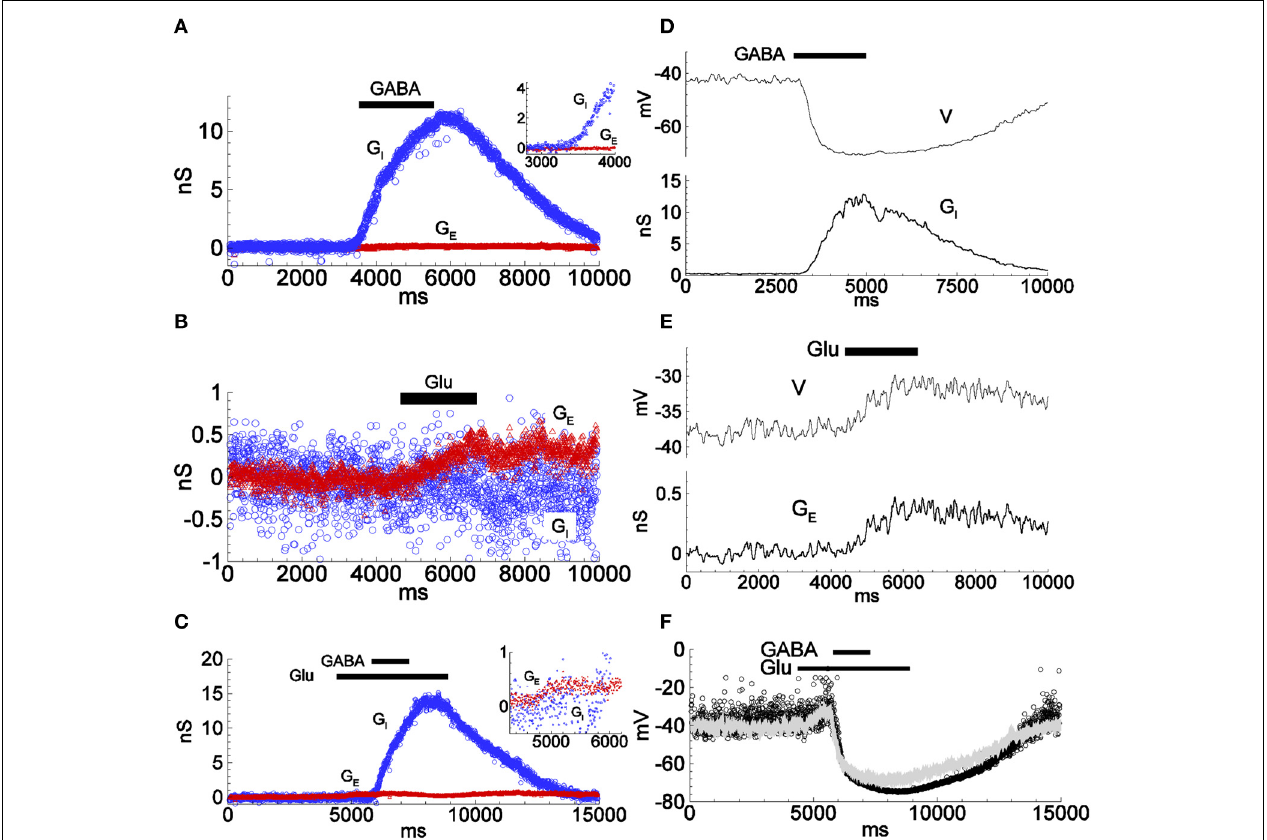
FIGURE 3 | Conductance estimations for responses to applied inhibitory and excitatory agonists using the firing-clamp and the continuous current-clamp methods. (A–C) Inhibitory and excitatory conductances were estimated by the firing-clamp method from recordings with extracellular application of either GABA (1.0mM) ( A ; see also Figure 2 ), glutamate (Glu; 1.0mM) (B) , or overlapping application of both agonists ( C ; inset highlights the excitatory component in response to glutamate) Each pair of subthreshold voltage and spike amplitude values evaluated at each probe spike was converted into a pair of excitatory and inhibitory conductances ( G E , G I ), according to the functions shown in Figures 1C,D , given reversal potentials V E = 0 and V I = − 74mV. (D,E) Conductance estimates (bottom traces in D , E ) from repeated continuous current-clamp recordings of membrane voltage at different holding currents. Inhibitory ( D , top) and